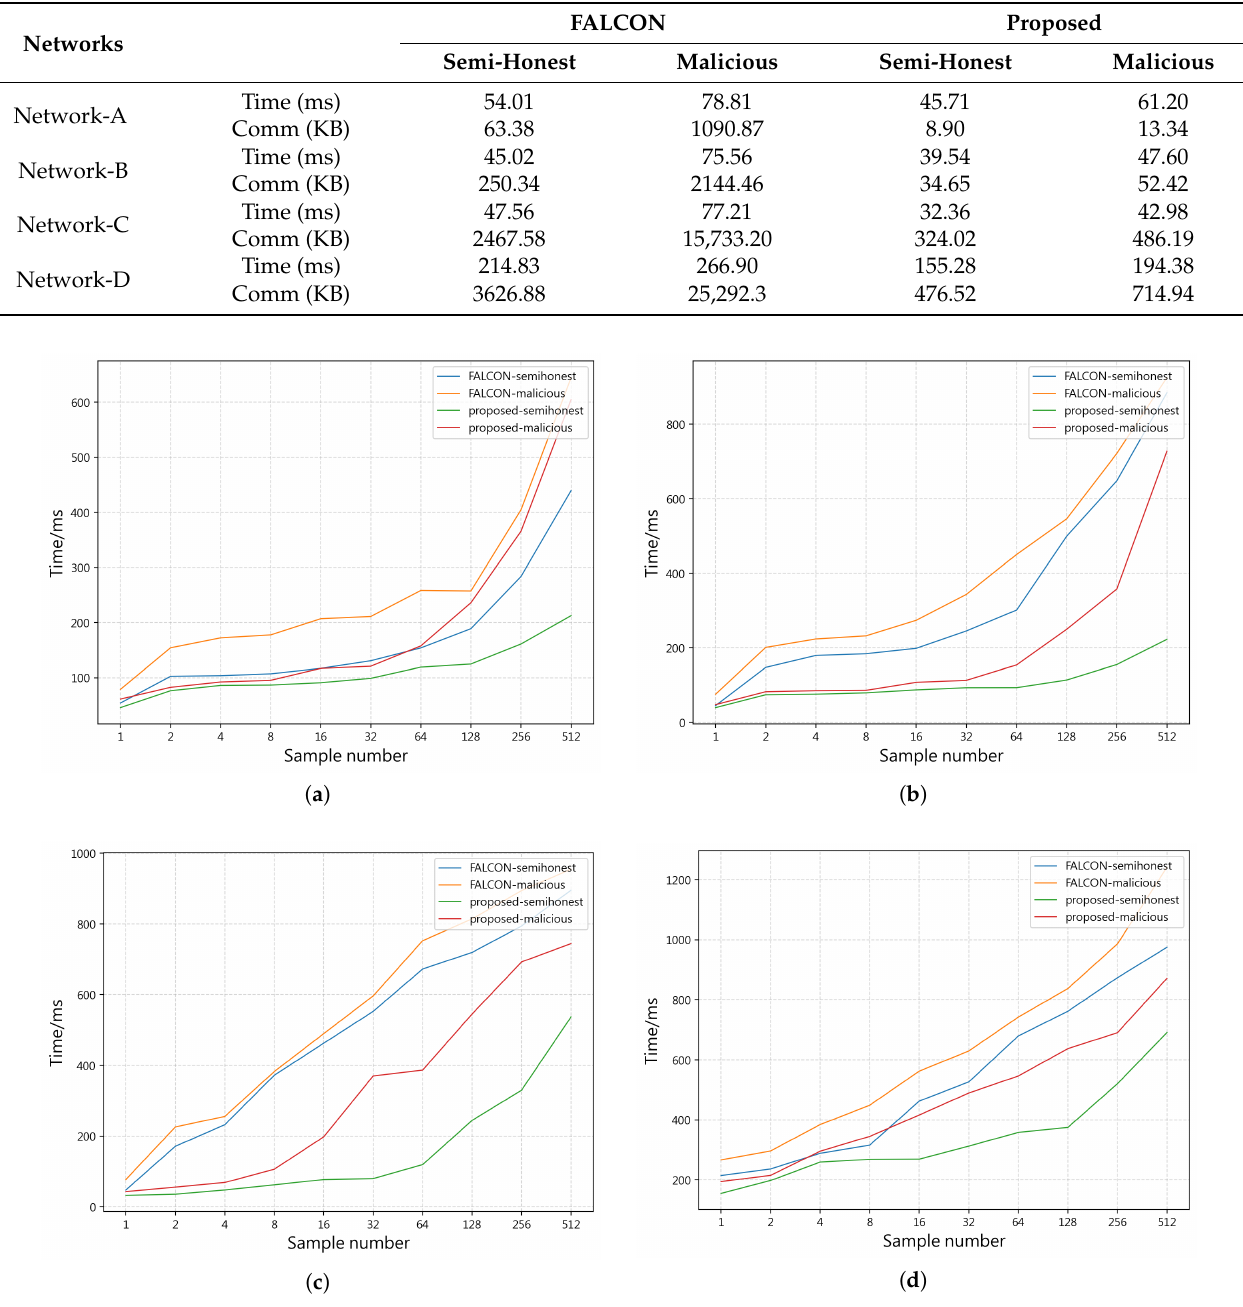
Figure 3. Prediction timings for batch size on Networks A-D over MNIST. ( a ) Network-A. ( b ) Network-B. ( c ) Network-C. ( d )